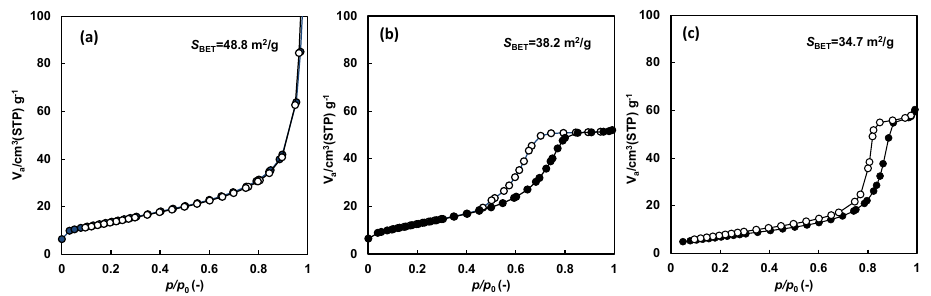
Figure 4. N 2 isotherms of ( a ) P25, ( b ) amorphous N/TiO 2 , and ( c ) anatase N/TiO 2 .